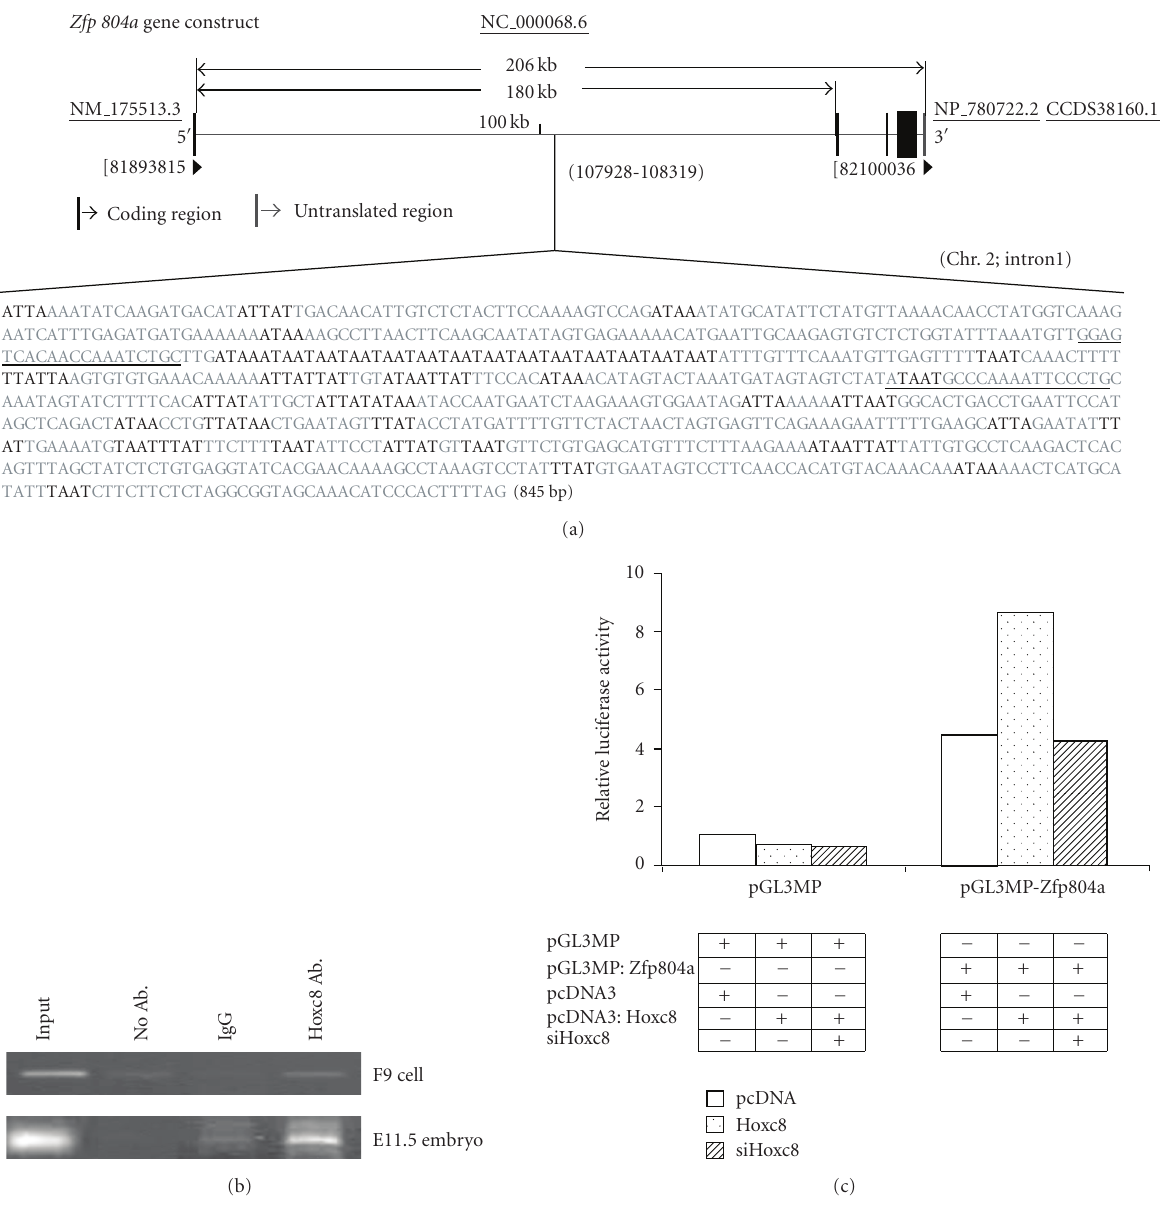
Figure 2: The mouse Zfp804a gene is located in chromosome 2 and has Hoxc8 responsive elements in the intron1 region. (a) Zfp804a gene organization. Coding regions or exons (black box) and the introns (grey box) are shown. Hoxc8-binding core sequences are shown in bold and the underlined sequences indicate primer targets for ChIP-PCR. (b) A ChIP experiment was performed using mouse E11.5 embryos and F9 cell line. The DNA-Hoxc8 complexes were immunoprecipitated by a Hoxc8-monoclonal antibody (lane 4). Input (prior to immunoprecipitation) was used for an internal control (lane 1), and mouse IgG and vehicle were used as a negative control (lane 3-4). (c) Hoxc8 activates Zfp804a in the e ff ector-reporter assay. Luciferase construct is driven by a minimal promoter fused to the intronic segment of Zfp804a (pGL3-MP: Zfp804a ; reporter) and cotransfected with a empty vector pcDNA3, pcDNA3:Hoxc8 (e ff ector), and a siRNA for Hoxc8 in F9 cells. Thirty-six hours after transfection, luciferase activities were measured. The experiments were performed in 3 independent trials. The mean values of the luciferase activity are shown as fold change relative over that of the